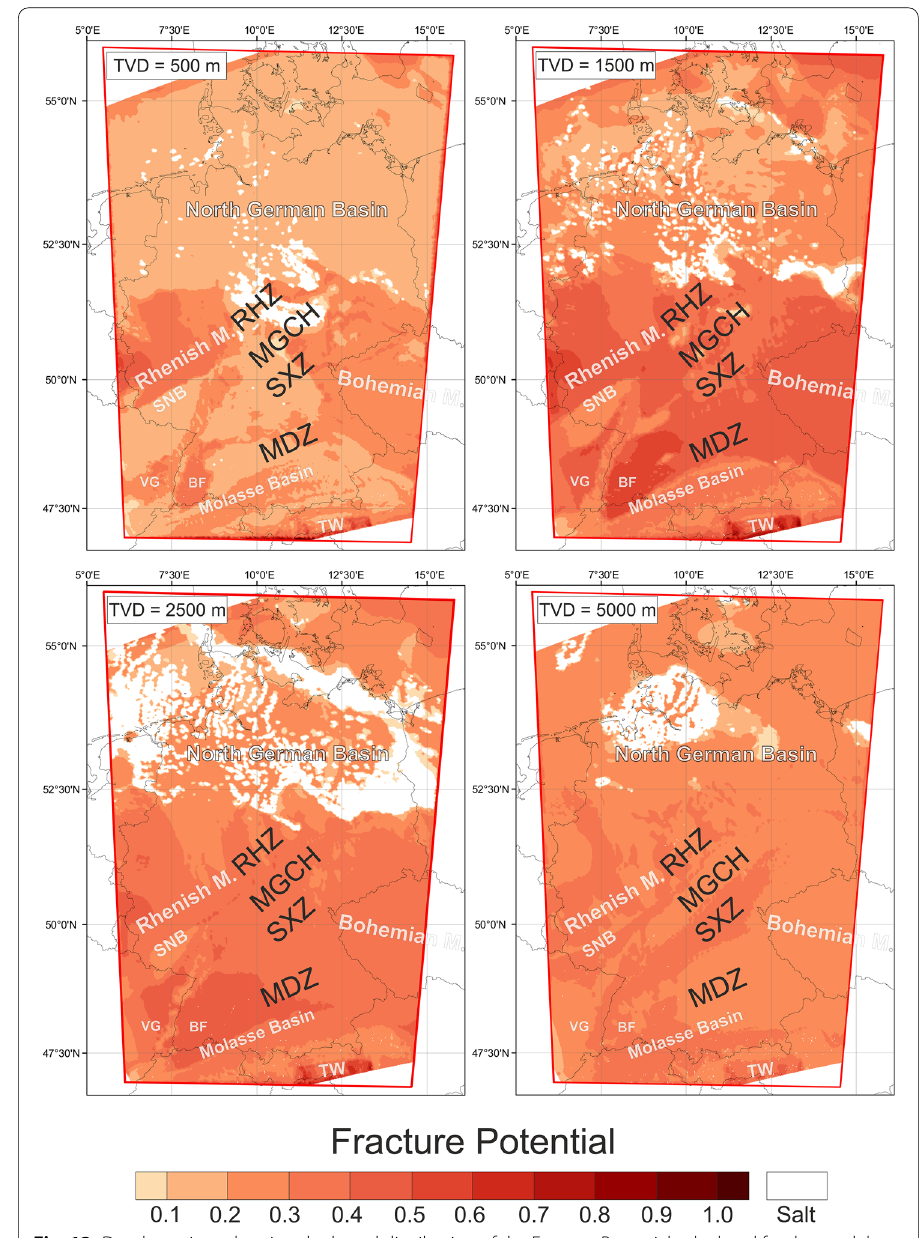
Fig. 13 Depth sections showing the lateral distribution of the Fracture Potential calculated for the model results. TVD—true vertical depth. Regions, where Zechstein salt occurs are left white. Black titles (details in Fig. 1d): MDZ—Moldanubian Zone, MGCH—Mid German Crystalline High, RHZ—Rhenoherzynian Zone, SXZ—Saxothuringian Zone. White titles (details in Fig. 1c): BF—Black Forest, M—Massif, SNB—Saar–Nahe Basin, TW—Tauern Window,